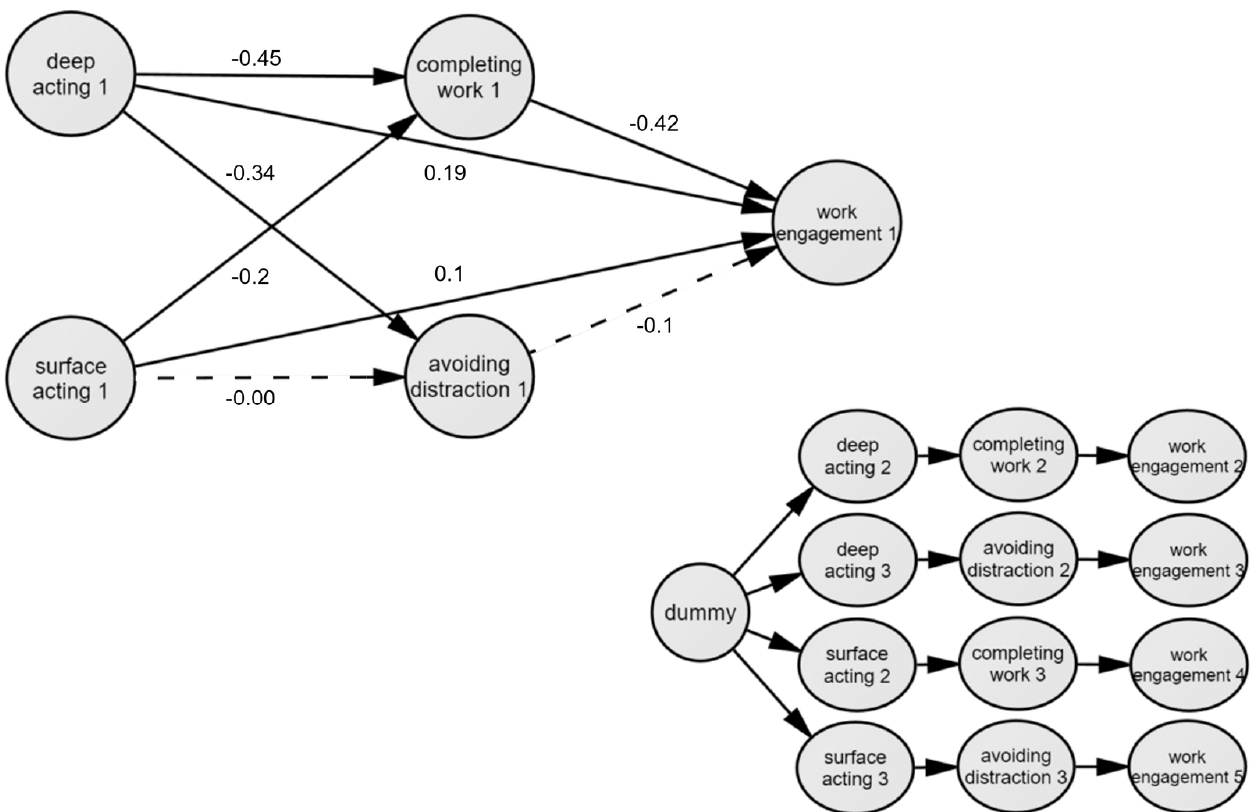
Figure 2. Mediation model using Phantom Model Approach. Table 6. Test of mediating effects.